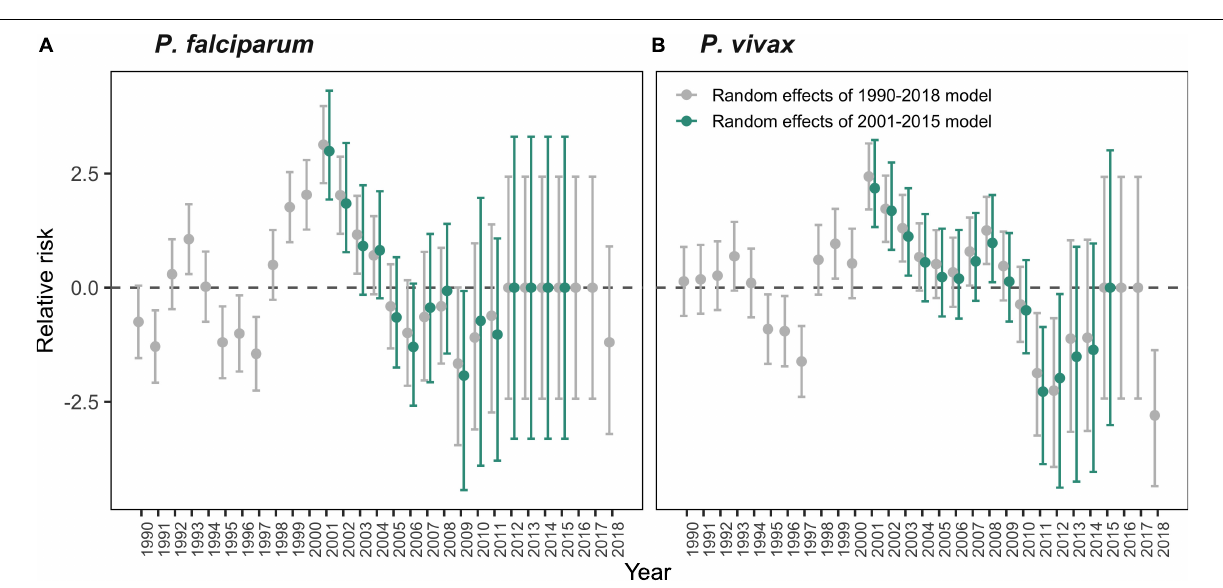
FIGURE 8 | Interannual random effects for malaria risk in El Oro 1990–2018. Difference in the interannual random effect marginal posterior distributions for (A) P. falciparum malaria models and (B) P. vivax malaria models. Distributions from the intervention model are shown in green, which include intervention data. Distributions from the full model are shown in gray, which does not include intervention data. Relative risk, on the log scale, is defined as the annual parasite incidence (API), log( ρ st